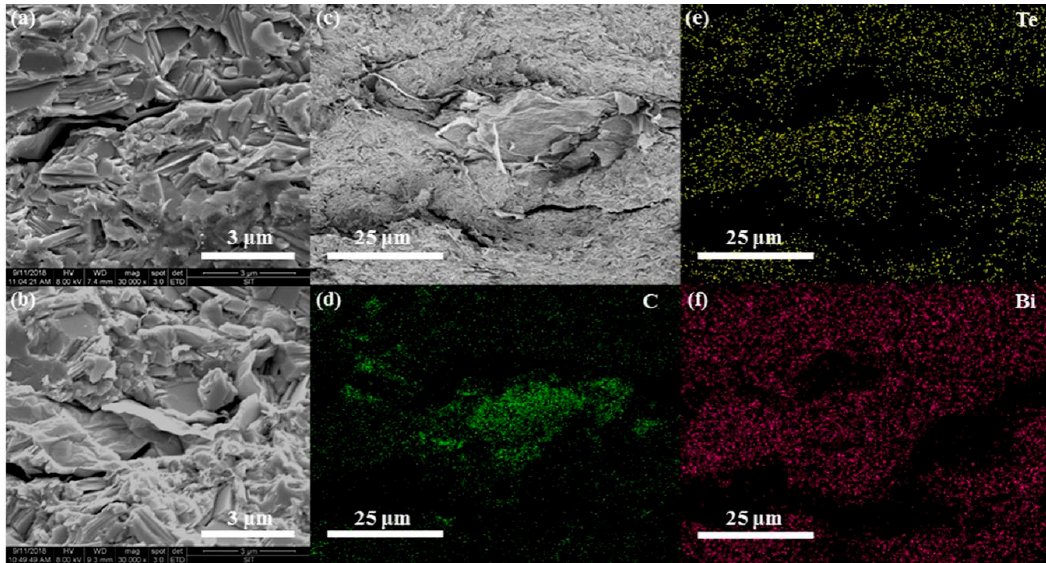
Figure 6. SEM images of rGO/Bi 2 Te 3 nanocomposite bulk materials with ( a ) 0.25 wt%; ( b ) 0.5 wt%; and ( c ) 1 wt% rGO; ( d – f ) are the corresponding SEM-EDS mapping images (C, Te, and Bi element) of the panel ( c ), respectively.